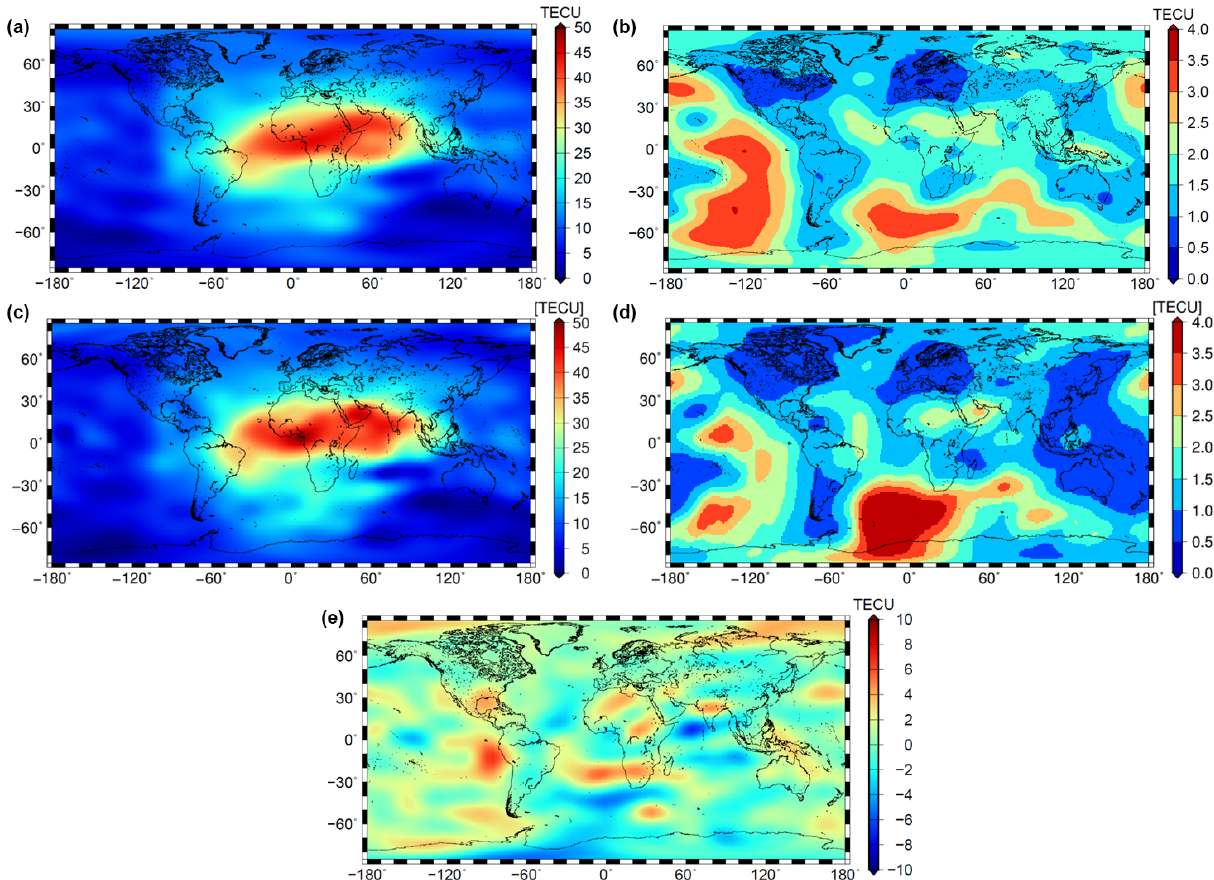
Figure 9. VTEC maps “codg” (a) and “o1lg” (c) as well as their standard deviation maps (b, d) ; difference map of the two VTEC maps (e) ; all data for 6 September 2017 at 13:00UT.